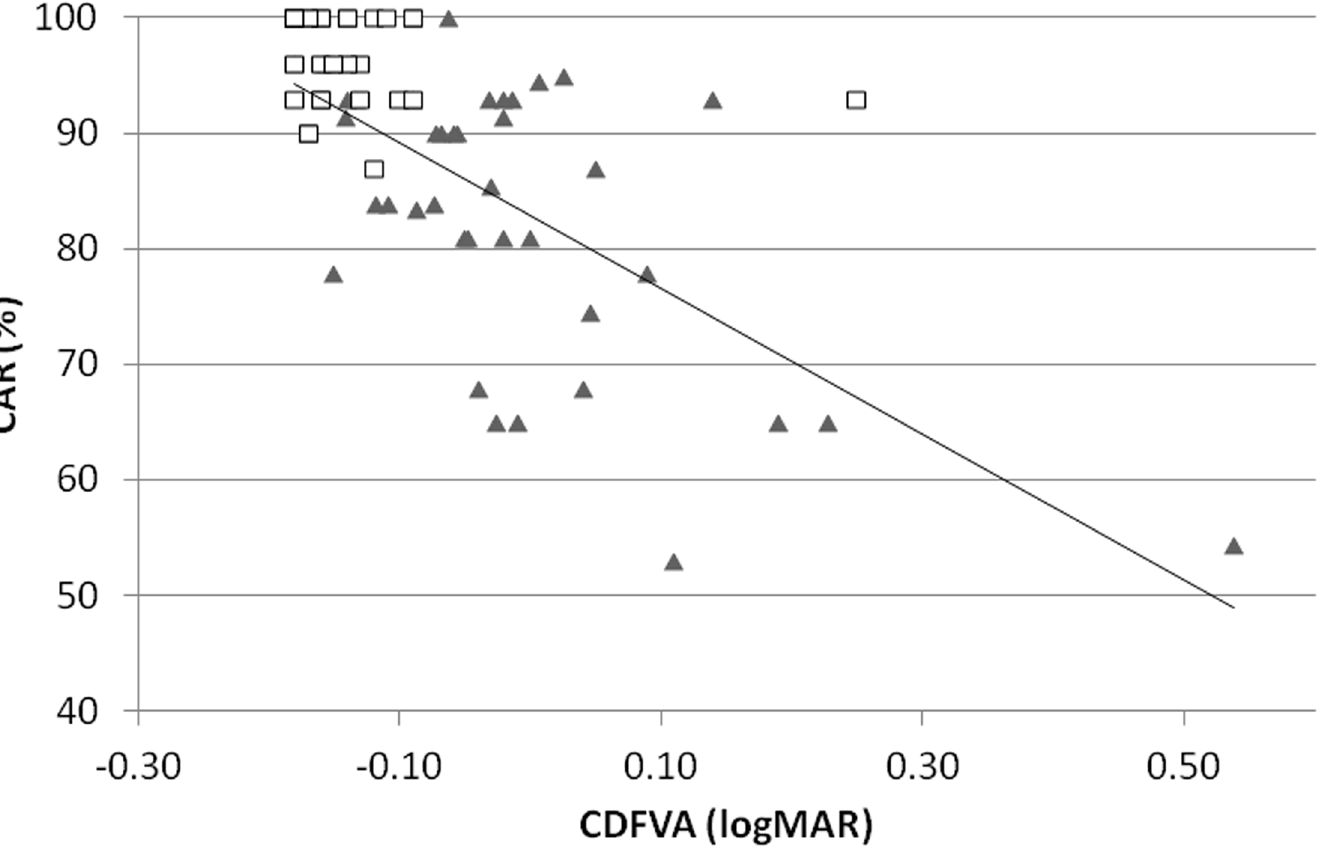
Fig 3. Correlation between the CDFVA and the CAR of the VFIT-EV. The correlation between the CDFVA and the CAR of the VFIT-EV is significant (r = -0.606, P = 0.000). The triangles indicate the data from the elderly group, and the squares indicate the data from the control